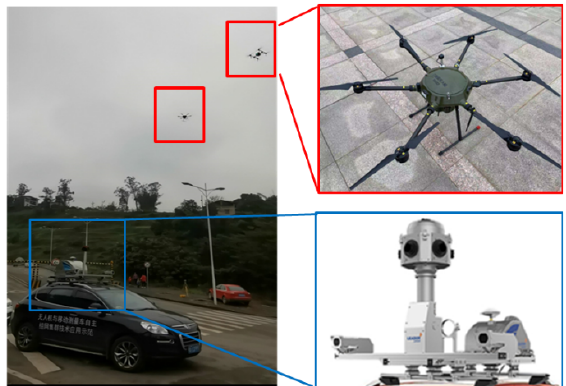
Figure 2 . Data acquisition of cooperative intelligent observation